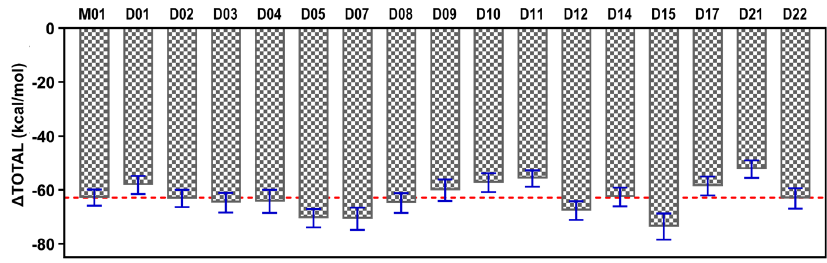
Figure 10. Comparison of the final ∆ TOTAL binding energy terms of the newly designed compounds. Compounds D02–D08, D12, D15, and D22 were estimated to have higher binding free energy compare to M01 (red dashed line) and the standard deviation sign is shown in